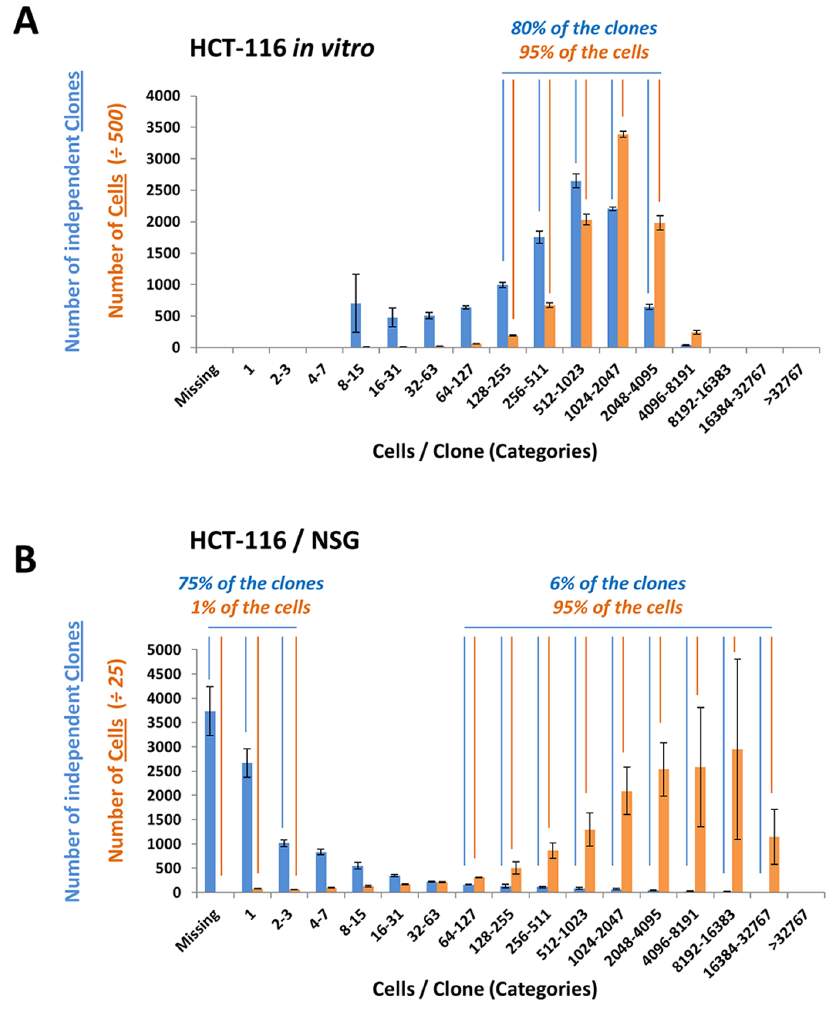
Figure 2. Evidence for clonal dominance: comparison of the distributions of HCT-116 barcoded clones and cells by clone size category invitro and invivo . For each graph, the number of independent clones (blue bars) or the total aggregate number of cells (orange bars) is plotted for each clone size category across the X axis. (A) Distribution of HCT-116 barcodes in vitro : 80% of the barcodes (clones) were identified in categories ‘‘128–255’’ to ‘‘2048–4095’’, indicating that 80% of the cells divided between 7 and 12 times; 95% of the cells were identified in categories ‘‘128–255’’ to ‘‘2048–4095’’, indicating that 95% of the cells belong to clones derived from 80% of the originally transduced cells, which divided between 7 and 12 times. Scale for number of cells was adjusted 500 fold to allow side by side comparisons of clone numbers and cell numbers. (B) Distribution of HCT-116 barcodes in vivo : 75% of the barcodes are found in categories ‘‘missing’’ to ‘‘2–3’’, indicating that they either didn’t survive at all, didn’t divide, or divided no more than once and represented only 1% of the retrieved tagged cells. However, only 6% of the bar-codes were located in categories ‘‘64–127’’ to ‘‘16384–32767’’, indicating that they divided between 6 and 14 times; 95% of the cells accrued in categories ‘‘64– 127’’ to ‘‘16384–32767’’, indicating that 95% of the tagged cells are derived from 6% of the initially barcoded clones that divided the most. Scale for number of cells was adjusted 25 fold to allow side by side comparisons of clone numbers and cell numbers. doi:10.1371/journal.pone.0067316.g002 generate clones with at least 64 cells (Fig. 2B – blue bars marked 6%). Remarkably, these clones accounted for 95% of the total aggregate number of cells within the tagged cell population (Fig. 2B